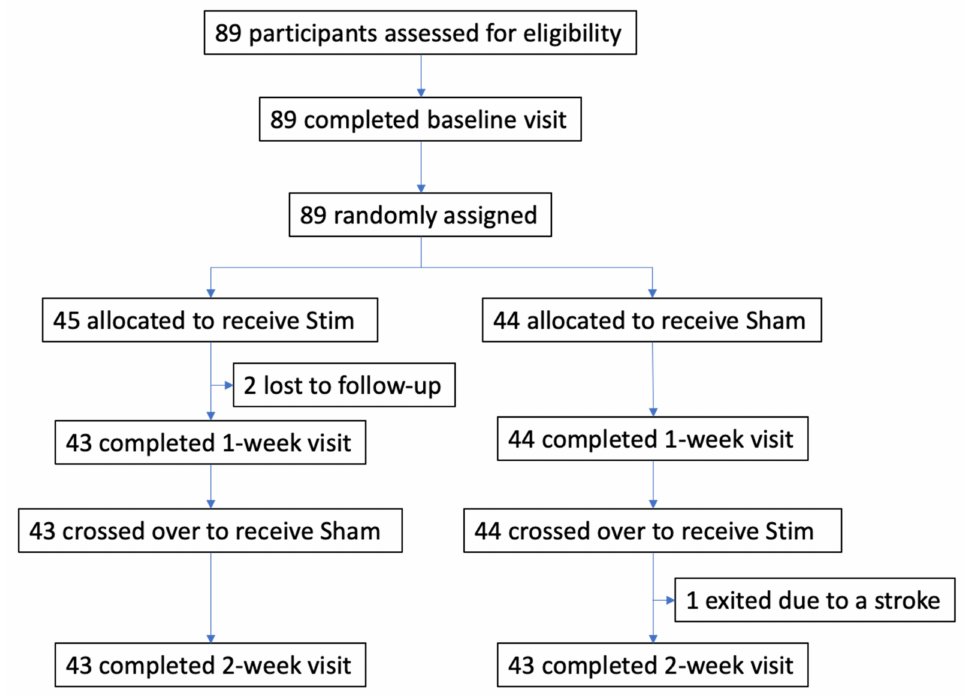
Figure 1. Flow diagram of the EFFECT randomized sham-controlled crossover